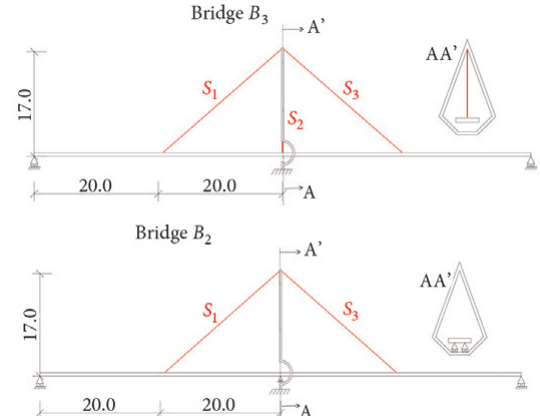
Fig. 2. Simplified examples of bridges B 2 and B 3 (dimensions in metres). Note: bridge B 2 has only 2 stays named S 1 and S 3 , and stay S 2 in bridge B 3 is aligned with the bridge mast